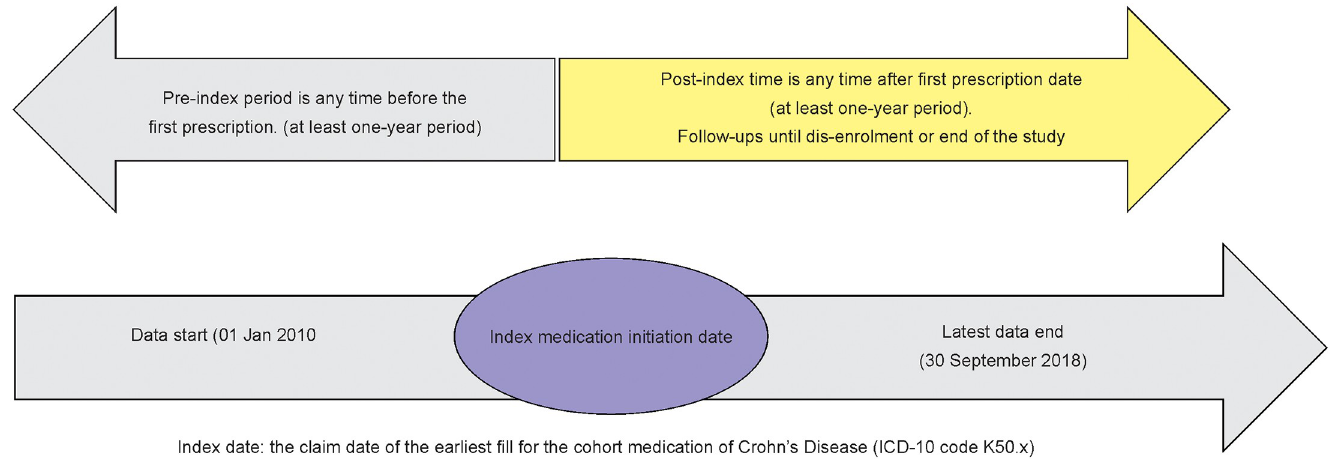
Fig 2. Study framework. Index date: the claim date of the earliest fill for the cohort medication of Crohn’s Disease (ICD-10 code K50.x).